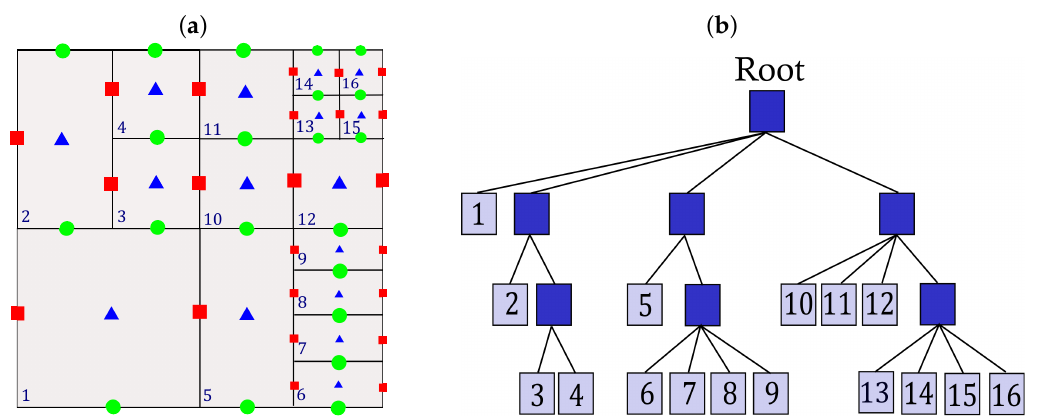
Figure 1. HiGTree data structure: ( a ) computational cell representation, ( b ) tree-based data structures.